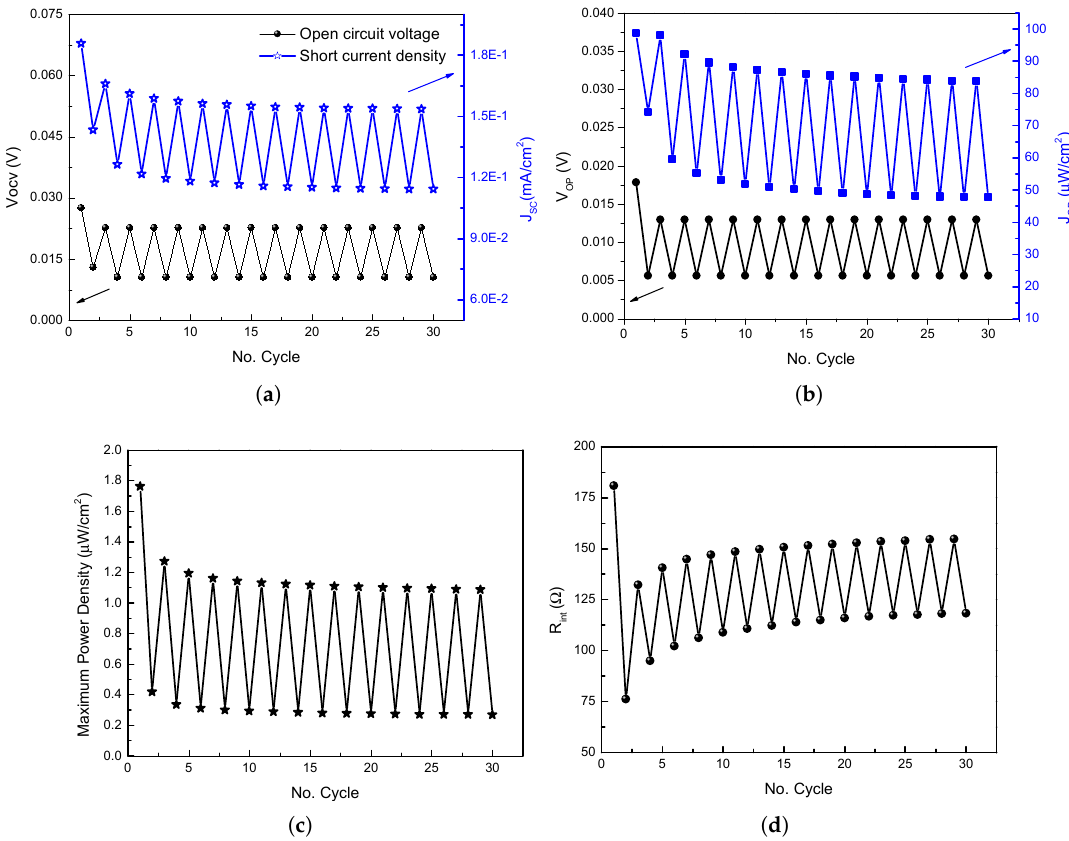
Figure 6. PMFC stainless steel membrane performance comparative: ( a ) open circuit voltage vs short current density; ( b ) optimal open voltage vs optimal current density; ( c ) maximum power density behavior; and ( d ) internal resistance